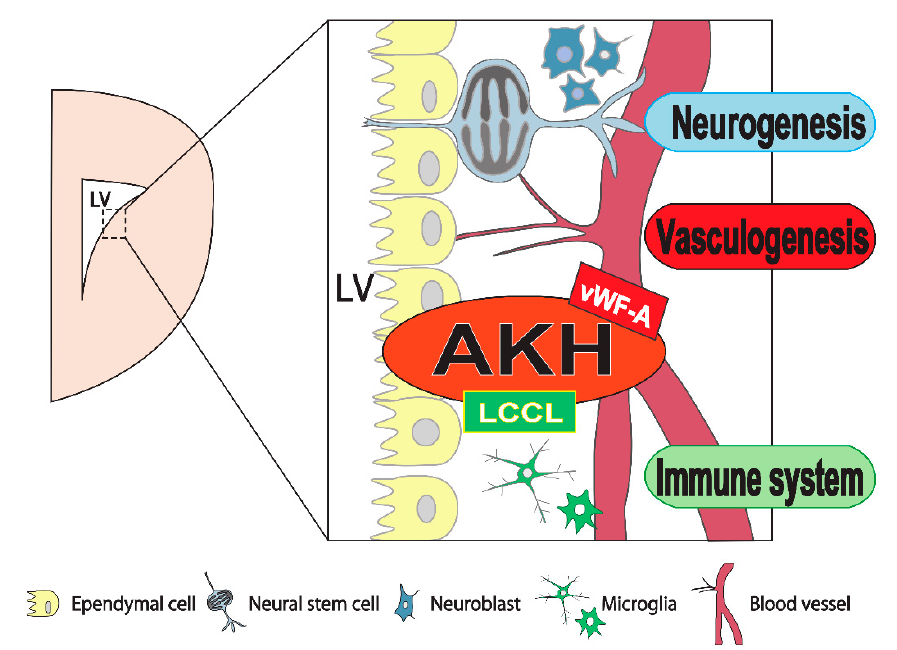
Figure 3. AKH is expressed in the neural stem cell niche and acts as a regulator. AKH is involved in the maintenance of neural stem cell proliferation, vasculogenesis, and the immune system during neurogenesis.